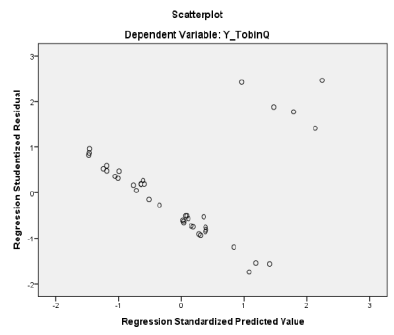
Figure 2: Residual Standard Regression Scatterplot